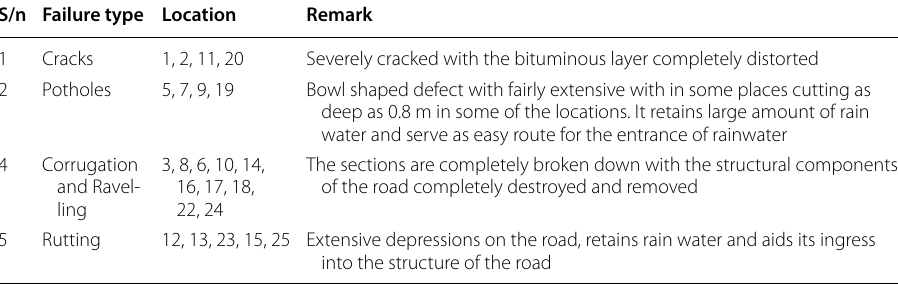
Table 1 Failure types and their locations on the studied